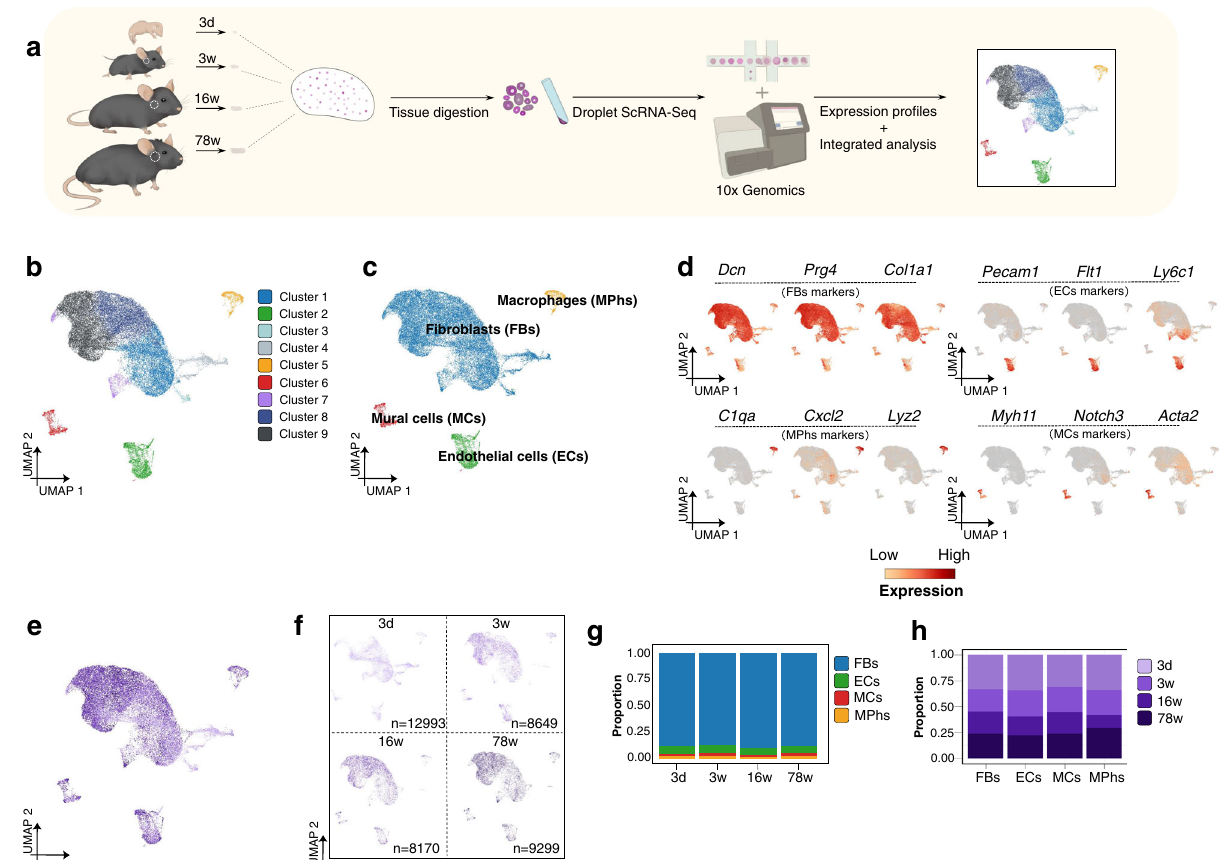
Fig. 1 | scRNA-Seq captures four main cell populations in mouse TMJ disc. a Schematic of the mouse TMJ disc tissues dissected for single-cell transcriptomic analyses. b Dimension reduction presentation (via UMAP) of combined single-cell transcriptome data from TMJ discs of newborn, juvenile, adult and aged mice ( n =39111). Eachdot represents a single celland is labeled with corresponding cell categories and colored according to its cell typeidentity. Clusters were generated using a resolution of 0.2 prior to subclustering into major cell types according to the Methods. The Seurat 3 R-Package segregationgrouped the cellsinto 9 distinct cell clusters. c Disc cells were classi fi ed into four principal cell types according to cell assemblies on the UMAP plot. Blue: fi broblasts (FBs), n =34420; yellow: mac- rophages(MPhs), n =2780;green: endothelial cells (ECs), n =1030;and red:mural cells (MCs), n =881. d Expression patterns of selected markers projected on the